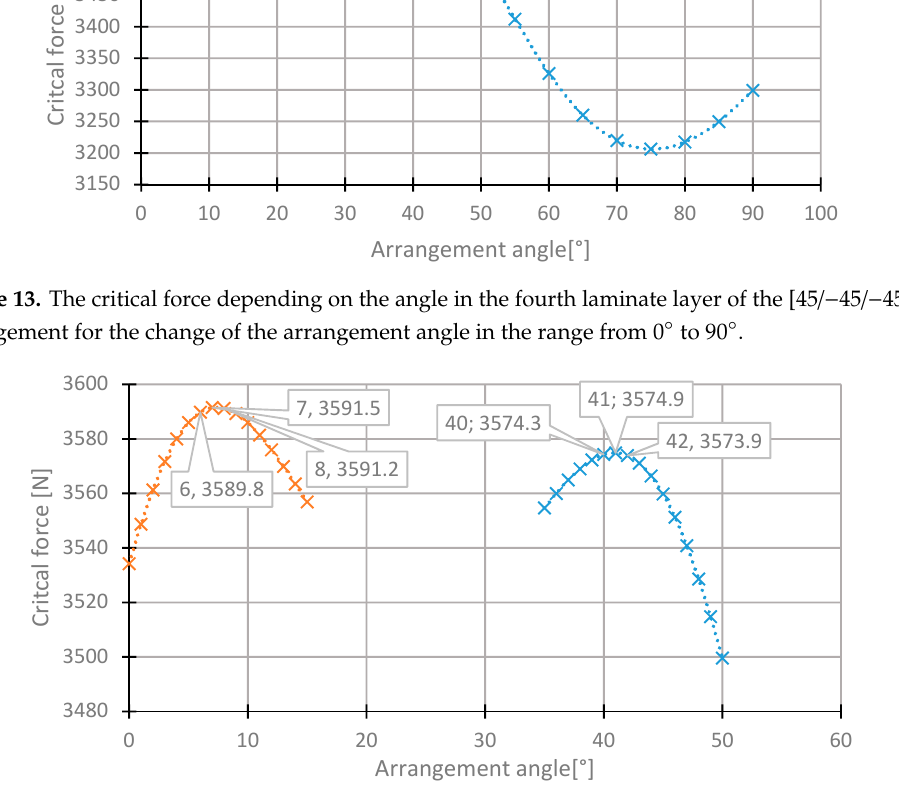
Figure 14. The critical force depending on the angle in the fourth laminate layer of the [45 / − 45 / − 45 / 45] arrangement for the change of the arrangement angle in the ranges 0°–15° and 35°–50°.